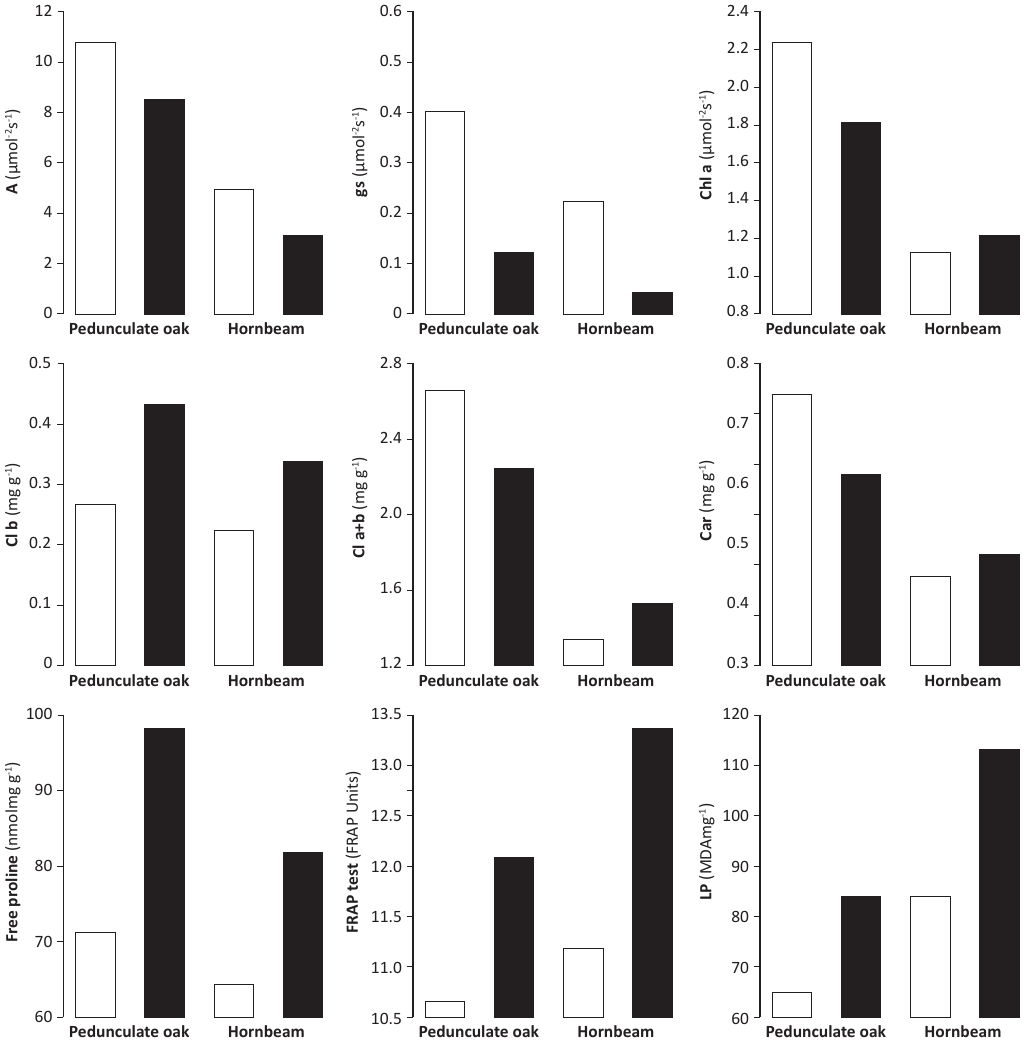
FiGUrE 1. Physiological and biochemical performances of irrigated ( ) and non-irrigated ( ) Pedunculate oak and Hornbeam saplings grown in urban area of Novi Sad, during August